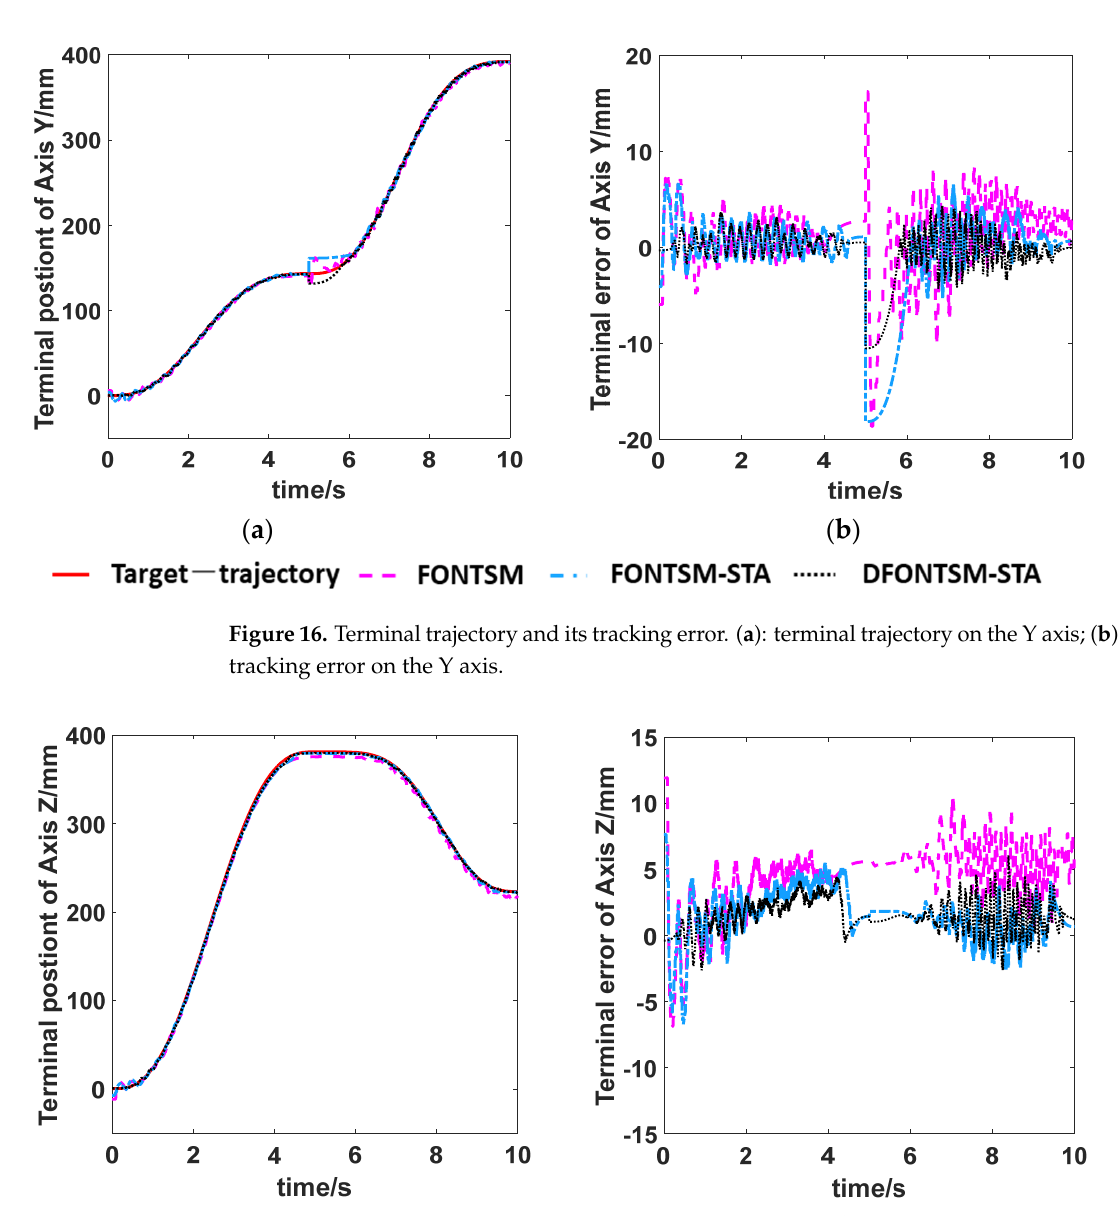
Figure 18. Terminal motion under base coordination system. ( a ): Terminal trajectory tracking curve; ( b ): initial part of the terminal trajectory tracking curve.